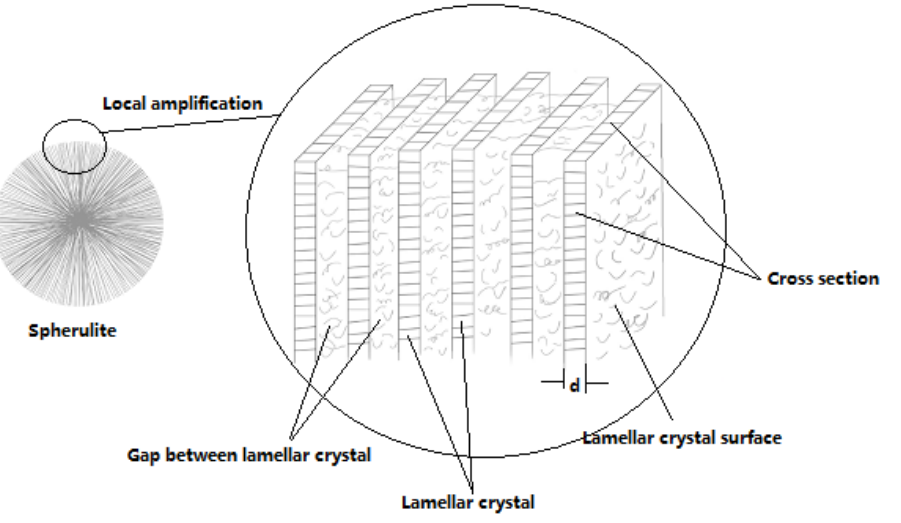
Figure 6. Schematic diagram of spherulite and lamellar crystal structure of polyethylene.